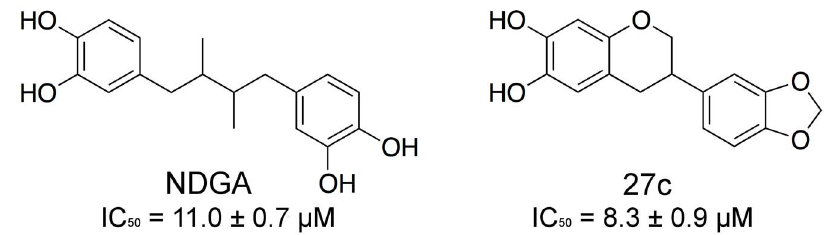
Figure 1. Current known 15-LOX-2 inhibitors (IC 50 values are in m M).